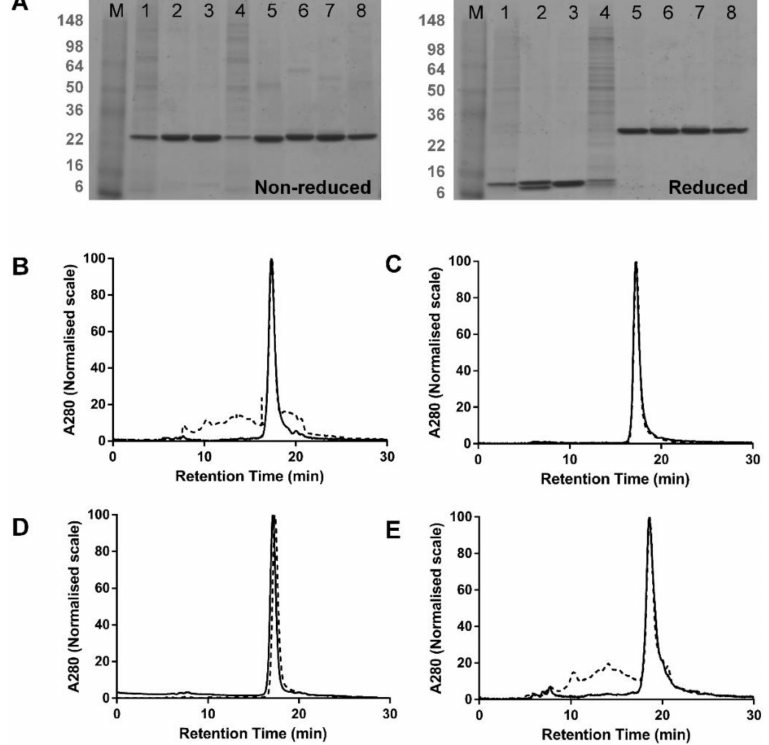
Figure 2. Multimerisation of dsFv vs. dsscFv. ( A ) Non-reducing and reducing SDS-PAGE analysis of dsFv and dsscFv proteins IMAC purified from 293F cells—representative data from one of three independent experiments are shown. M—molecular weight marker; lane 1—dsFv#1; lane lane 8—dsscFv#4. ( B – E ) S200 SEC profiles of purified dsFv and dsscFv proteins. ( B ) dsFv/dsscFv#1; ( C ) dsFv/dsscFv#2; ( D ) dsFv/dsscFv#3; ( E ) dsFv/dsscFv#4. Dashed lines represent dsFv;